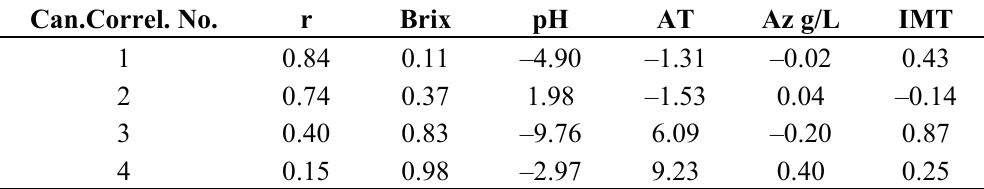
Table 5. CCA coefficients of the first four canonical correlations for red musts of